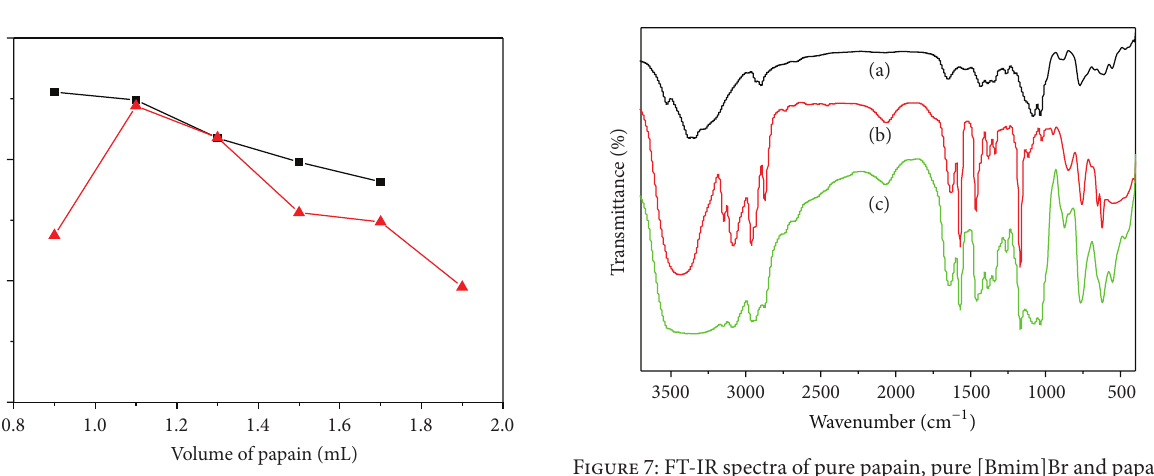
Figure 7: FT-IR spectra of pure papain, pure [Bmim]Br and papain in [Bmim]Br. (a) Pure papain; (b) pure [Bmim]Br; (c) papain in